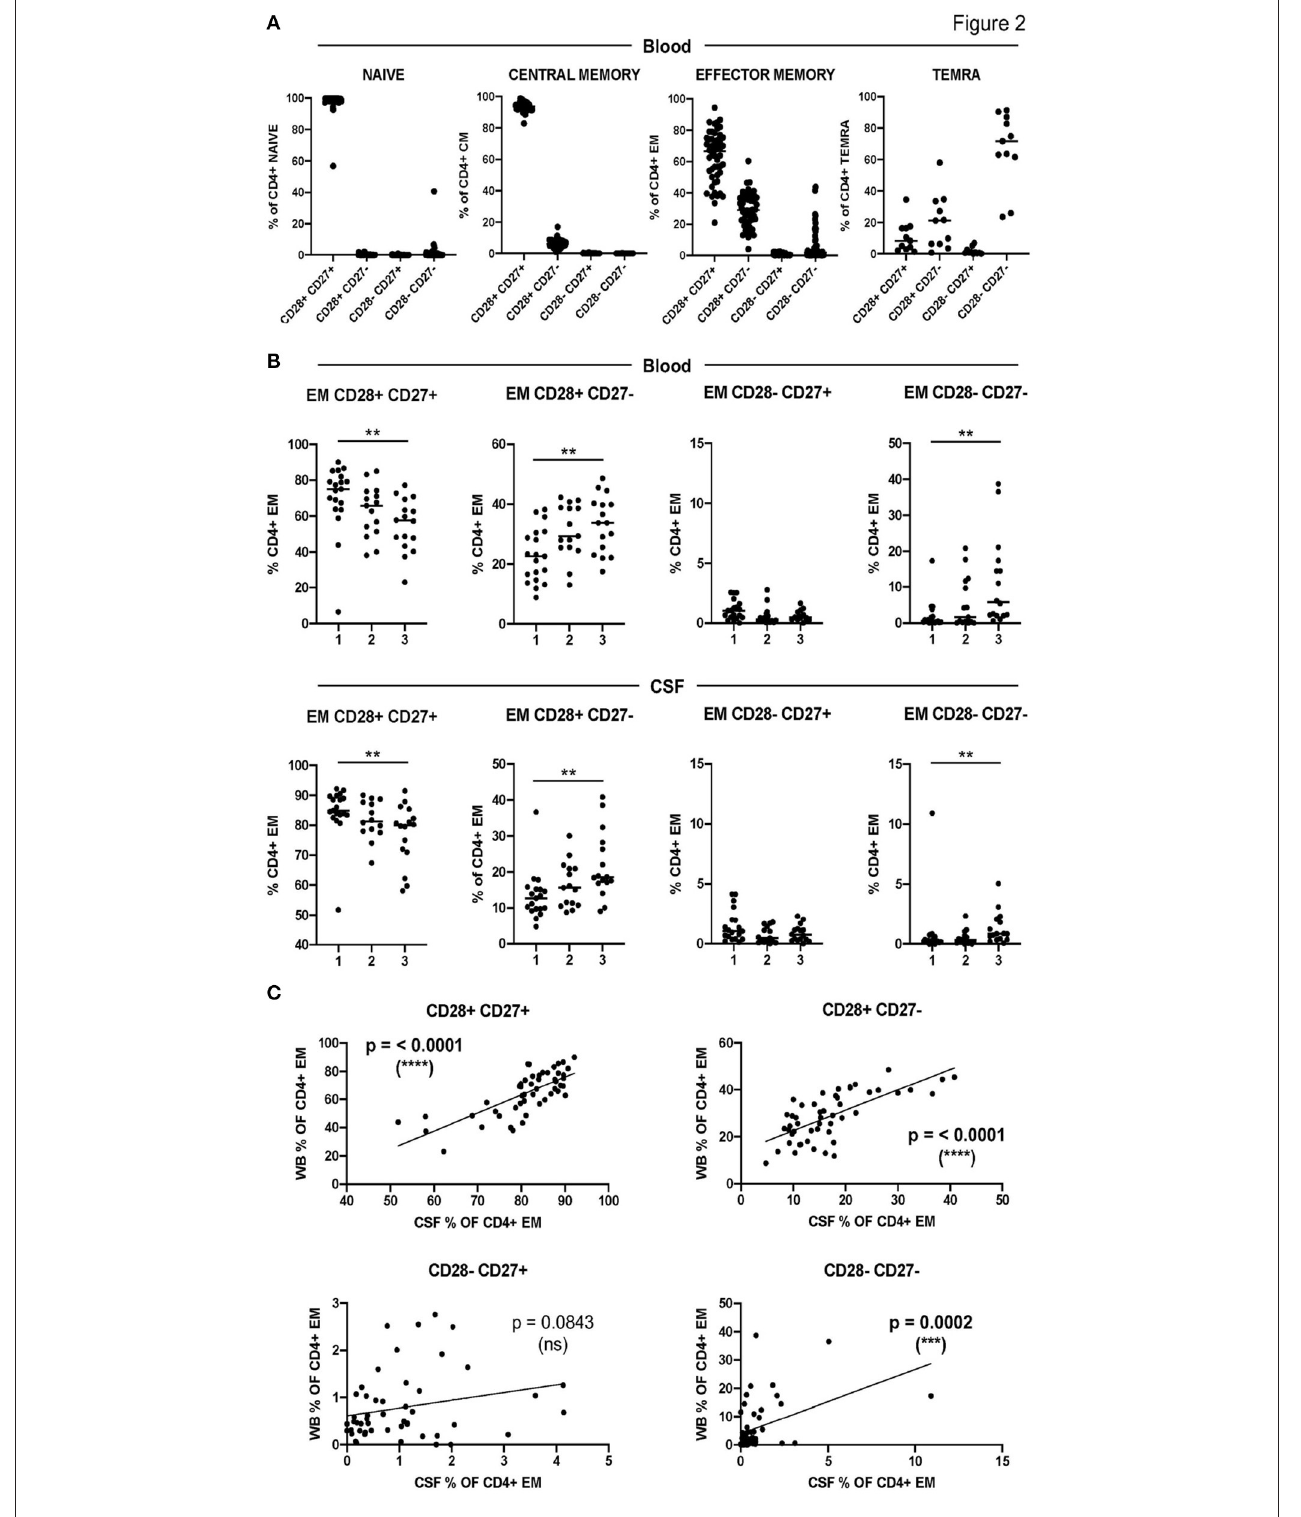
FIGURE 2 | Characterization of CD4 + T-cell senescence using the downregulation of CD28 and CD27. (A) Frequencies of CD28 + CD27 + , CD28 + CD27-, CD28- CD27 + , and CD28- CD27- cells among circulating naïve-, CM-, EM-, and TEMRA CD4 + T cells. (B) Frequencies of CD28 + CD27 + , CD28 + CD27-, CD28- CD27 +